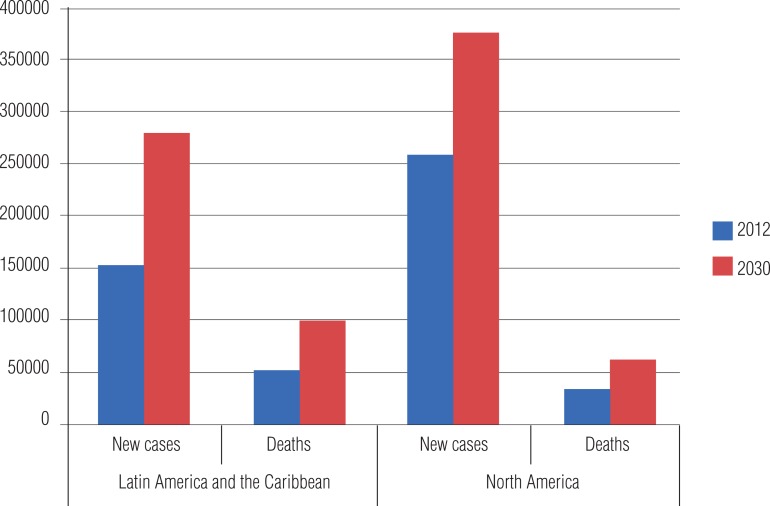
Estimate of new cases and deaths due to prostate cancer in 2012 and 2030, in the Americas.